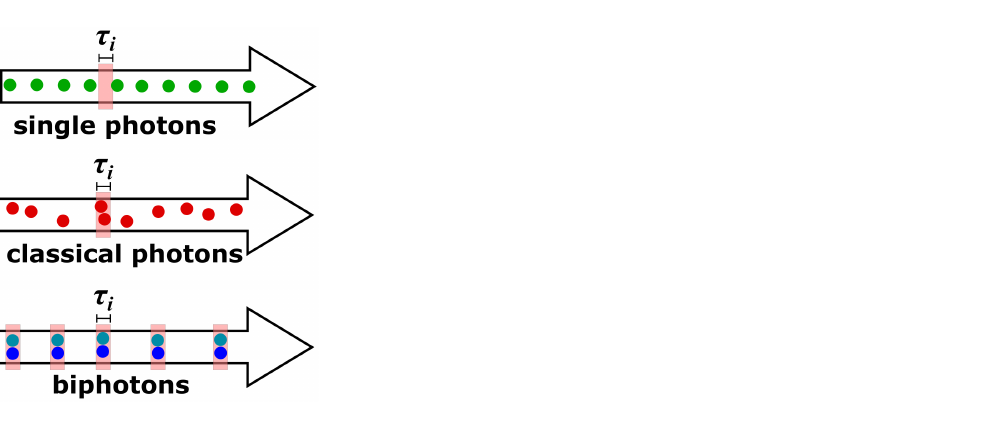
Figure A1. Illustration of the correlation of the emission from different light sources with respect to a time window τ i . Upper graph: perfect single photon source with no two-photon correlations, middle graph: classical light source with random two-photon correlation and lower graph: perfect two-photon source that emits photon pairs or “biphotons” with perfect two-photon